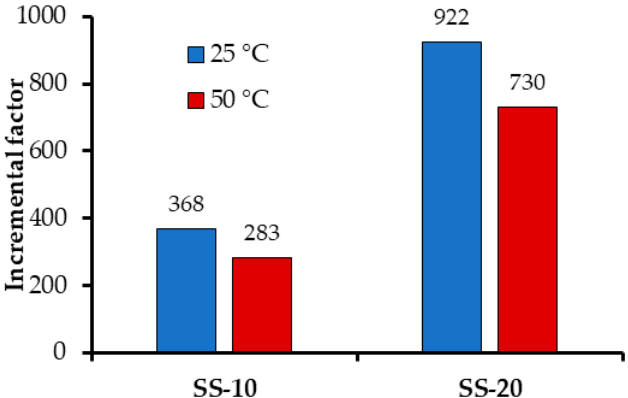
Figure 8. The incremental factor for CO 2 adsorption at 2.5 MPa and 25–50 °C. Sandstone impregnated with CN.RON2 at mass fractions of 10% and 20%. Incremental factor based on the CO 2 adsorption capacity of sandstone without impregnation.